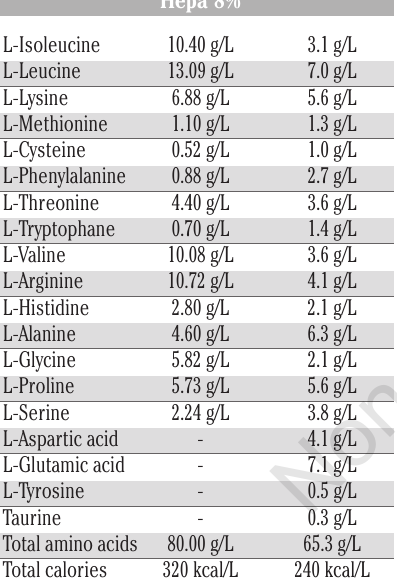
Table 2. Comparison of composition between the amino acid solutions Aminosteril Hepa 8% and Vaminolact for parenteral use: Vaminolact is the normally used product for parenteral nutrition in preterm infants in our hospital. Aminosteril Hepa 8% is a product designed for patients with liver diseases with low content of phenylalanine and was therefore suitable for application in our PKU patient. It does not contain any tyrosine, but our patient maintained sufficient Tyr plasma levels with the application of little amounts of Phe-free